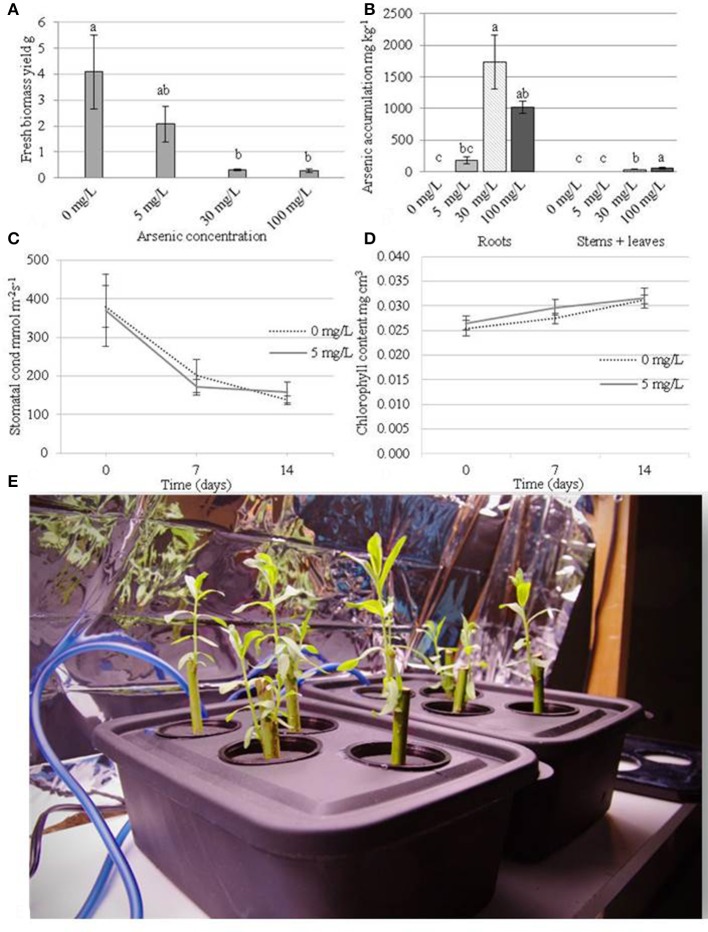
Physiological measurements of the plants during arsenic exposure. Plants were cultivated for 14 days before treatment with arsenic concentrations of 0, 5, 30, or 100 mg/L. (A) Fresh weight biomass yield (g) after 14 days of treatment (28 days of growth). (B) Arsenic accumulation in organs after 14 days of treatment. (C) Chlorophyll content mg.cm3 (day 0 represents treatment application date). (D) stomatal conductance mmol.m−2s−1 (day 0 represents treatment application date). Error bars represent standard error (n = 4 blocks). Tukey's Honestly Significant Difference (α = 0.05) is represented by lettering. (E) a photograph of the hydroponic tanks (15 × 25 × 12 cm = 3.8 L).